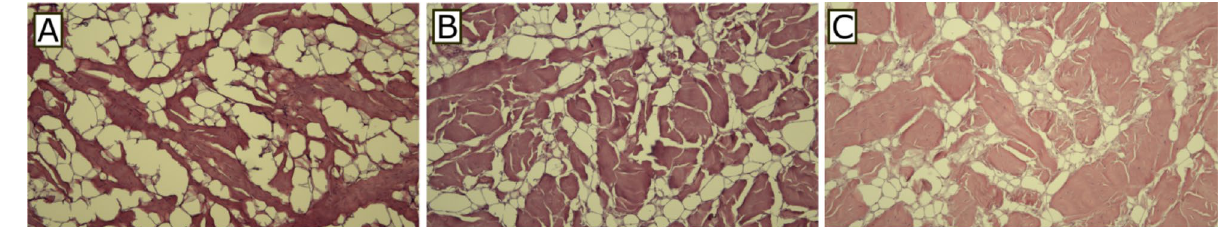
Figure 3. Adipocyte images (white is lipid—filled adipocyte; red is intervacuolar space) from blubber samples obtained during post-mortem examination of a non-fasting ( A ) and two fasting ( B , C ) male pygmy killer whales that stranded on August 29 ( A ) and September 24, 2019 ( B , C ) in Ma ʻ alaea Bay,